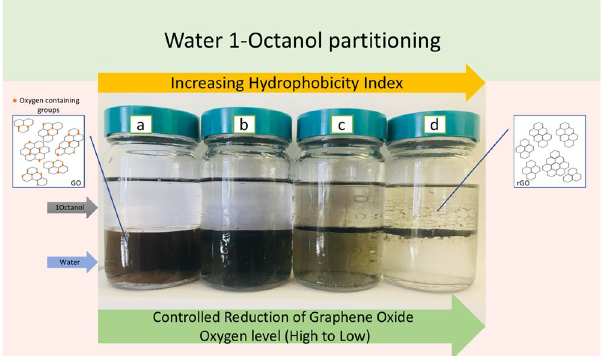
Figure 5. Photographs of 1-octanol/water partitioning of ( a ) GO, ( b ) r-GO-31, ( c ) r-GO-19, ( d ) r-GO-9 after standing for an